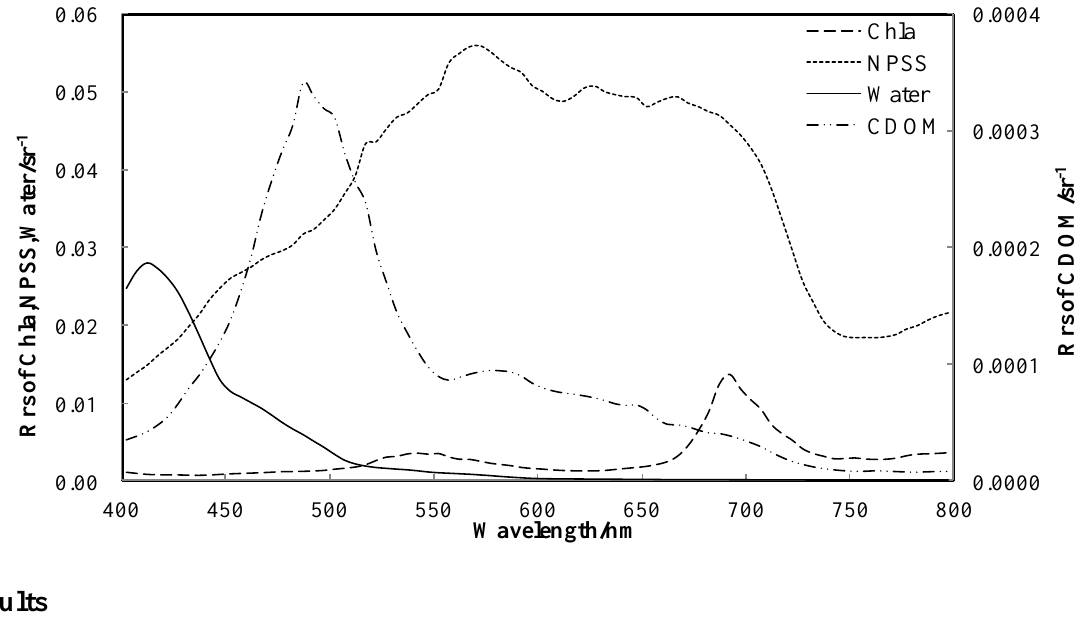
Figure 3. The standard spectra of end-members (water, Chla, NPSS, and CDOM)